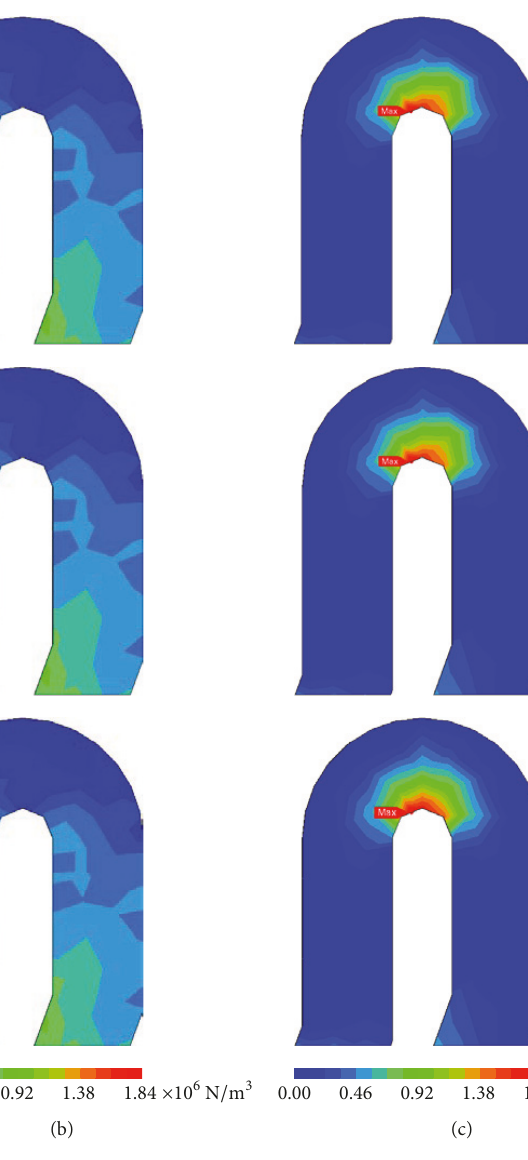
= 221 mm (bottom), 𝑙 = 321 mm sc sc